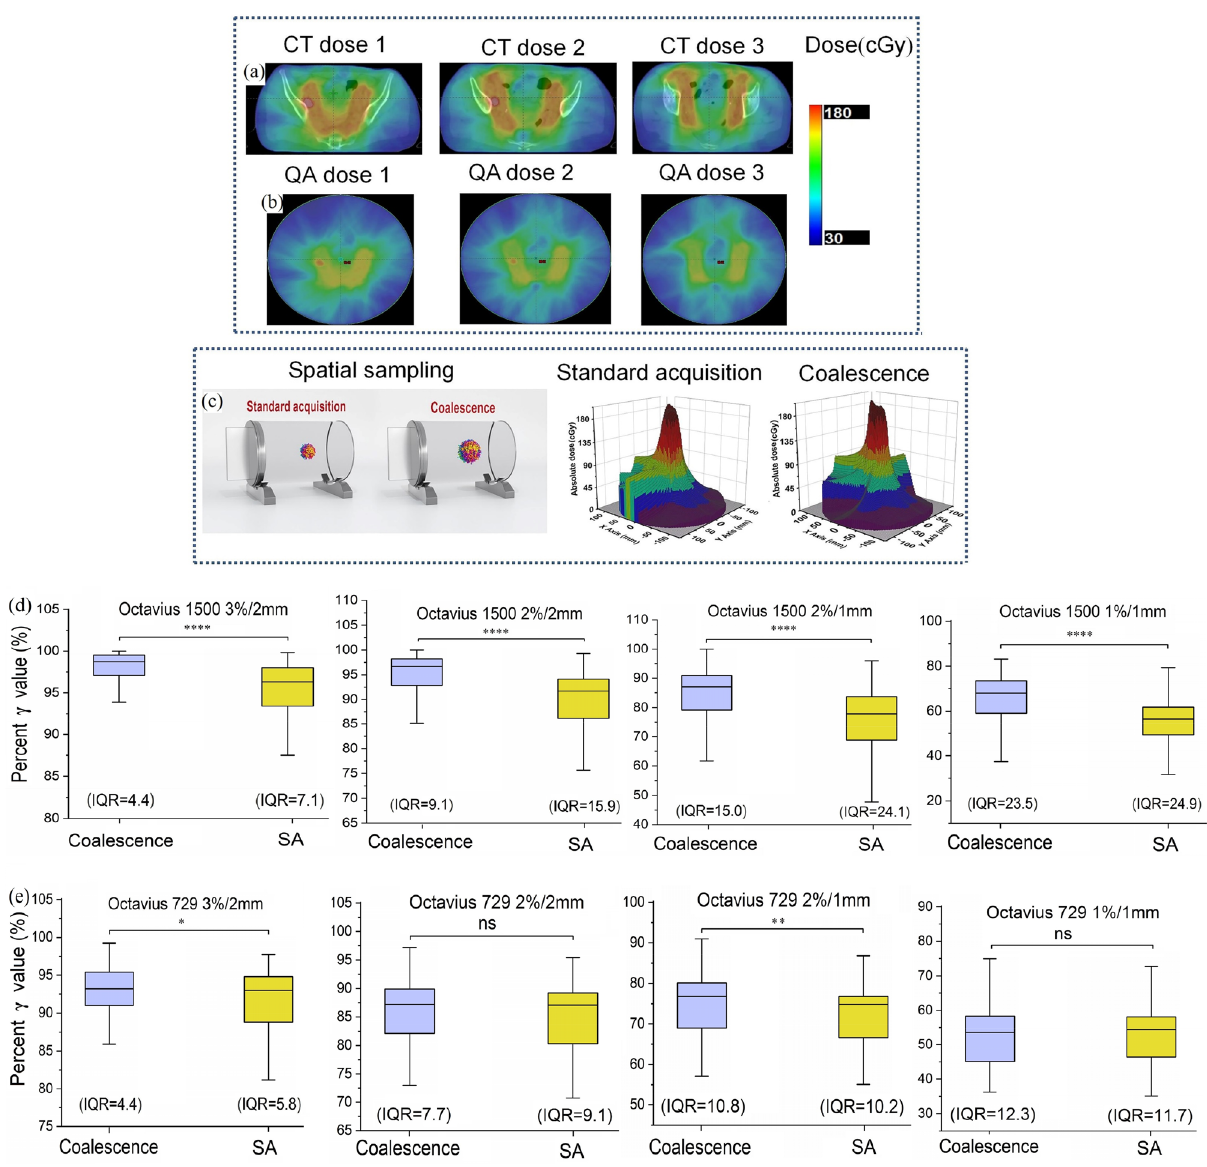
Figure 3. Schematic diagram and percent γ index results in coalescence and SA cohorts. (a,b) An example of transverse dose-maps on CT image-based treatment plans and detector-based QA plans correspondingly. Colors indicate dose magnitude. (c) Coalescence procedure yields double spatial sampling points compared with standard acquisition (left figure). (d,e) The γ results in coalescence versus SA cohorts at different acceptance criteria. As showed by box plots, centerlines show the medians, box limits indicate the 25th and 75th percentiles, and whiskers extend to the minimum and maximum. If there were statistically significant differences between coalescence and SA cohorts, IQR in coalescence cohorts was lower than in SA cohorts. Asterisk indicated the statistically significance at a 5% level (two-tailed). ****P < 0.0001, ***P < 0.001, **P < 0.01, *P < 0.05, ns: P > error and random dose error, i.e., artificially introduced different errors. The γ values and its difference between no-error and induced-error cases for each of the eight VMAT cases in coalescence and SA cohorts in both detec- tors, at 3%/2 mm criteria with global vs local normalization, are displayed in Fig. 5a–h (Fig. 5a,c,e,g showed results of global normalization, Fig. 5b,d,f,h showed results of local normalization). Additionally, ROC curve was used to further assess sensitivity and specificity in separating IE cases from NE cases in various resolution scenarios. A similar trend was detected for DLG and MU errors in that the sensitivity in coalescence cohorts was not higher than that in SA cohorts. For DLG error, there was case-specific different sensitivity, namely, mixed higher ( (cid:31) γ < 0) and lower ( (cid:31) γ > 0) γ values in IE cases compared to those in NE cases, as shown in Fig. 5a–d. Consequently, ion chamber detectors were unable to accurately separate DLG error of 1 mm regardless of coa- lescence or SA procedures, while areas under ROC curve were slightly greater than 0.5 (Fig. 5i,k). To further verify this result, we have performed the experiments again using the strictest criteria of 1%/1 mm (global nor-